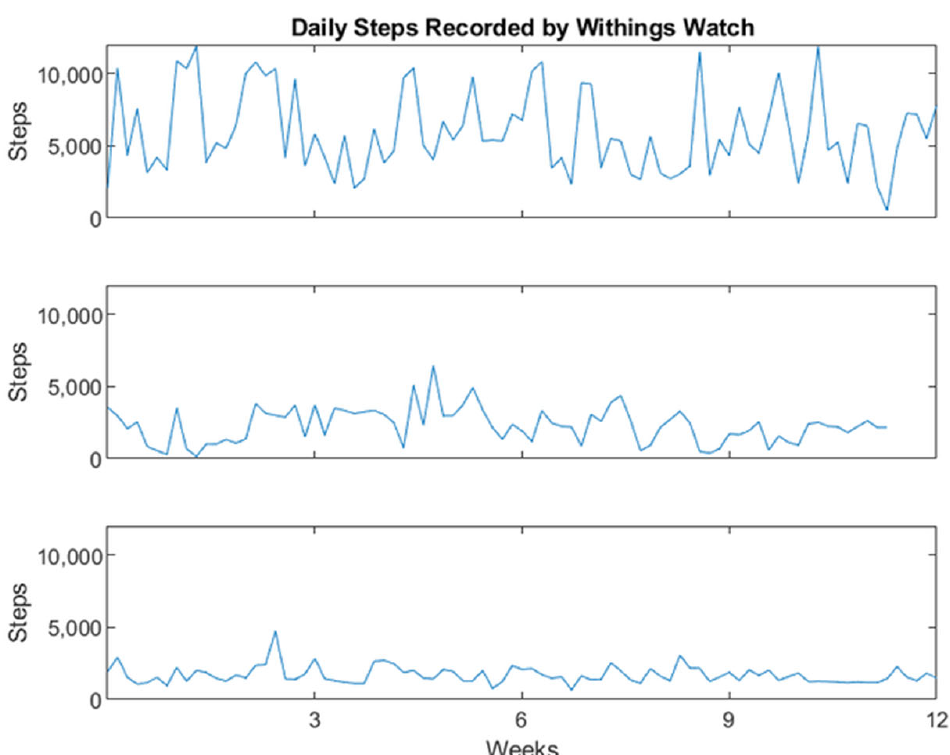
Figure 3. Daily total step counts for three representative study participants as measured using the Withings Activite watch.